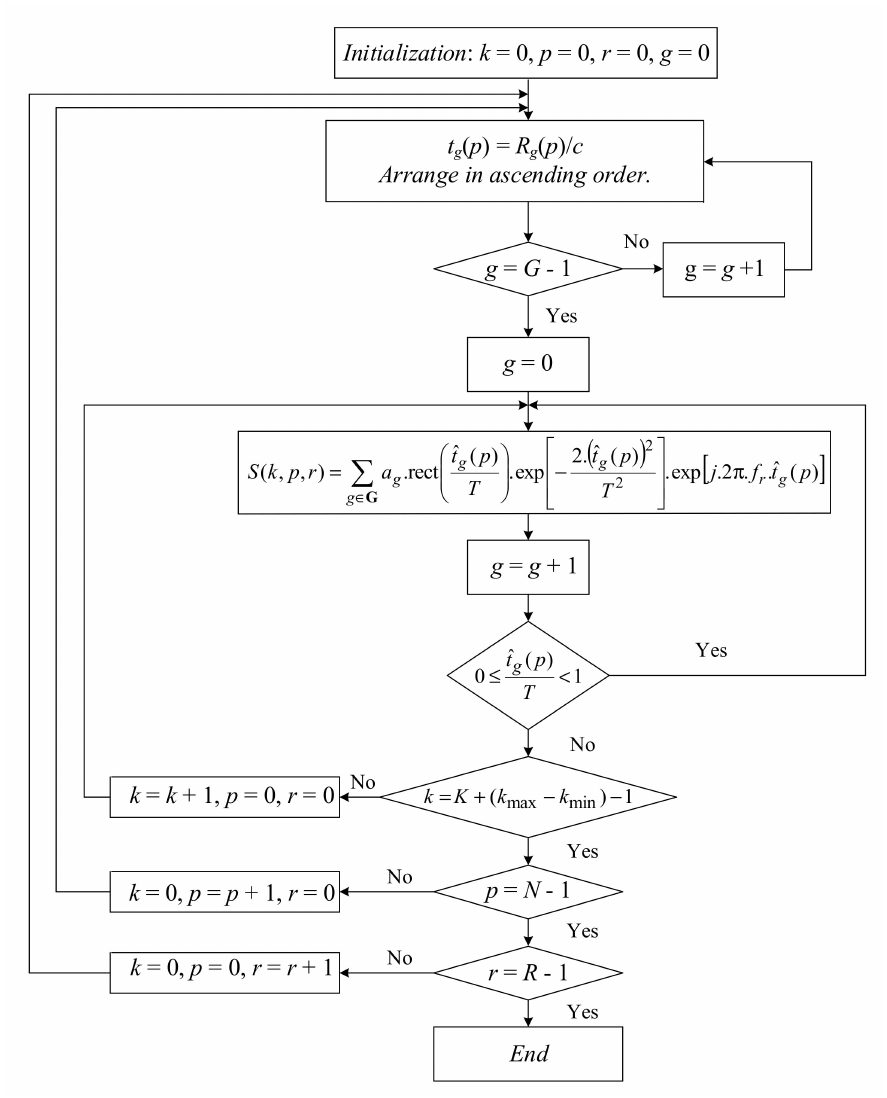
Figure 4. Flow chart of asteroid’s ISAR signal